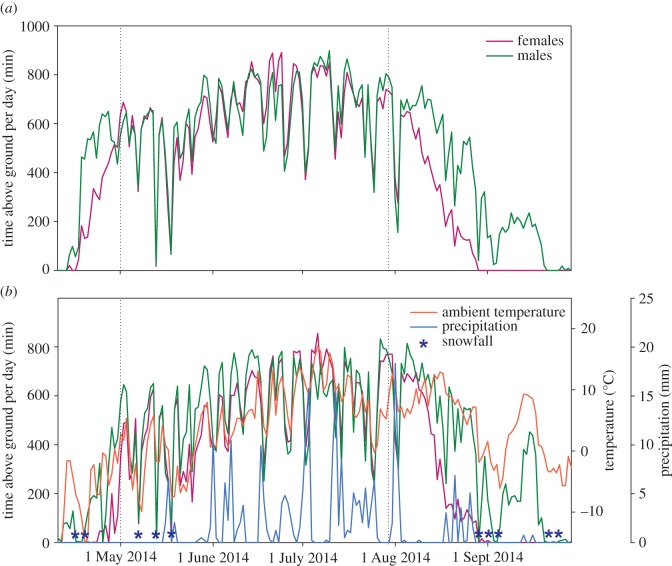
Mean duration (minutes) spent above ground each day in 2014 for female (purple) and male (green) arctic ground squirrels at our field sites at (a) Atigun River and (b) Toolik Lake. Time above ground varies substantially from one day to the next owing to the effects of environmental conditions known to affect thermal exchange including mean ambient temperature (red line), total daily precipitation (blue line), blizzard events (blue asterisks), solar radiation (not shown) and wind speed (not shown). The vertical dashed lines indicate the start and end dates for the data used in the mixed model, which excludes intervals when any individuals were hibernating.